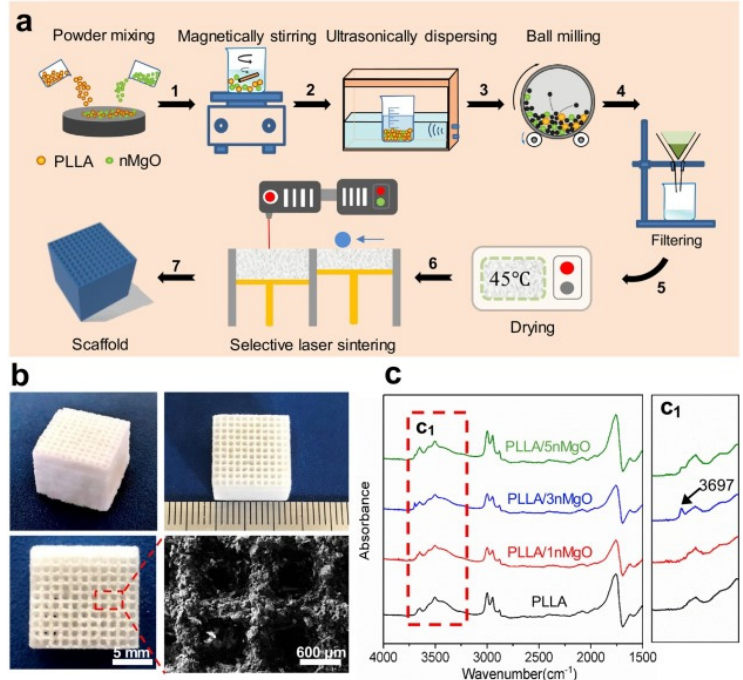
Figure 4. PLLA/n-MgO stent preparation and testing process. ( a ) The fabrication process of scaffolds, ( b ) the digital photographs of representative PLLA/nMgO scaffold, and ( c ) Fourier transform infrared spectrometer (FTIR) analysis results of the scaffolds [95].